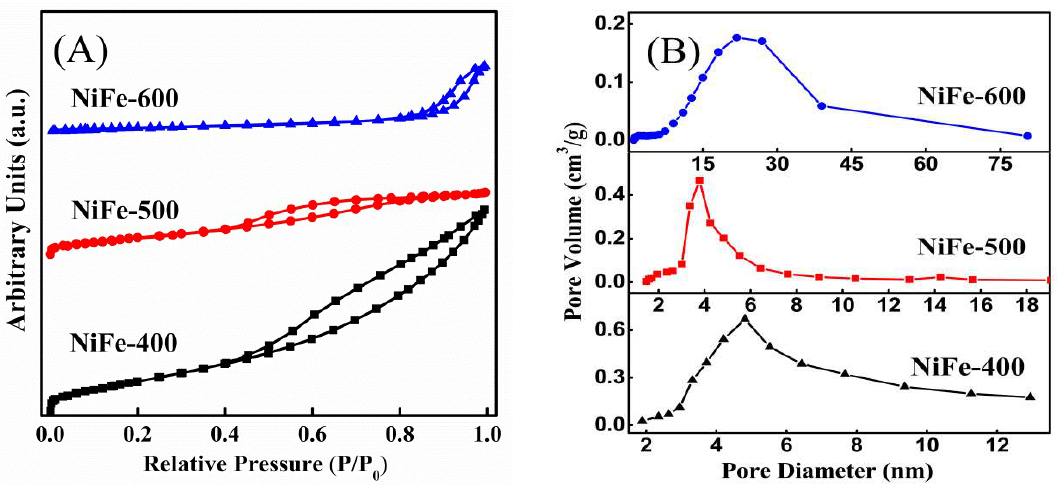
Figure 4. N 2 adsorption and desorption isotherms ( A ) and pore diameter distribution ( B ) of the serial NiFe-LDO catalysts.